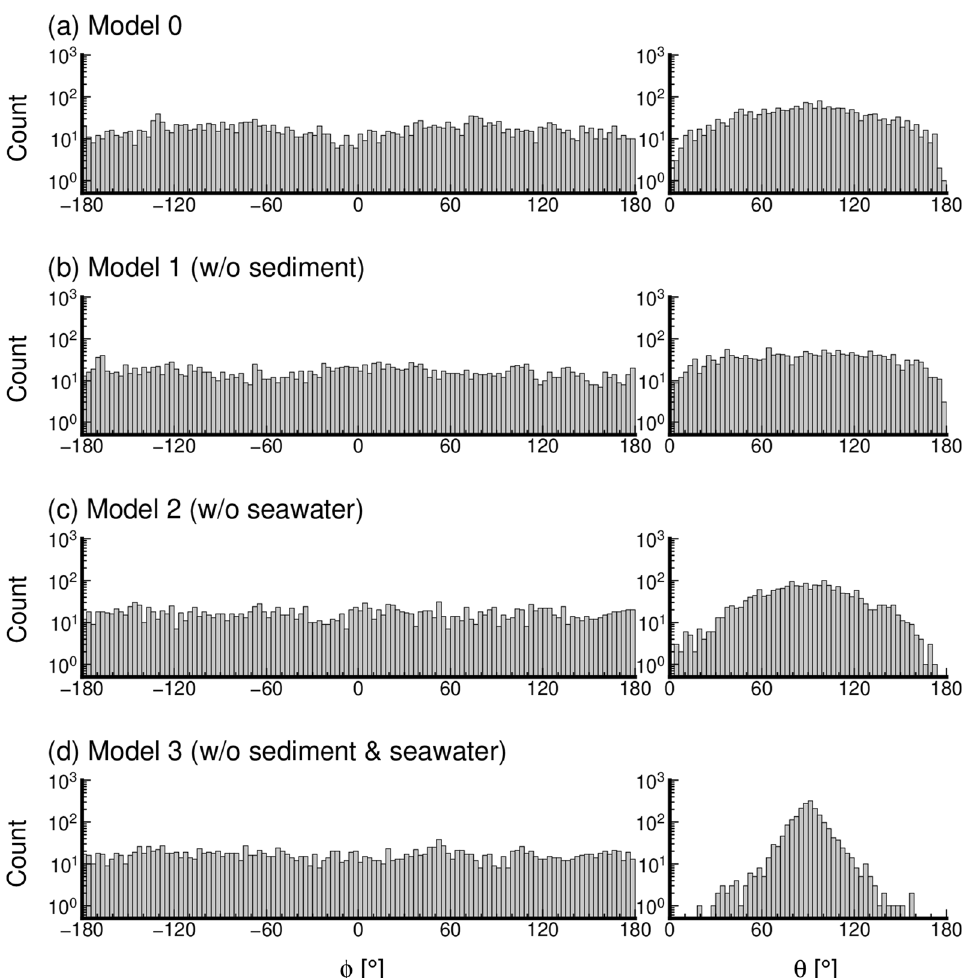
Fig. 11 Distributions of directions of energy flux for coda waves in various types of heterogeneous models. The angle θ is measured from the Z -axis, and θ 0 means a downward propagation. The angle φ i s the horizontal azimuth measured from the X-axis. The X-axis is similar to that = described in Fig.